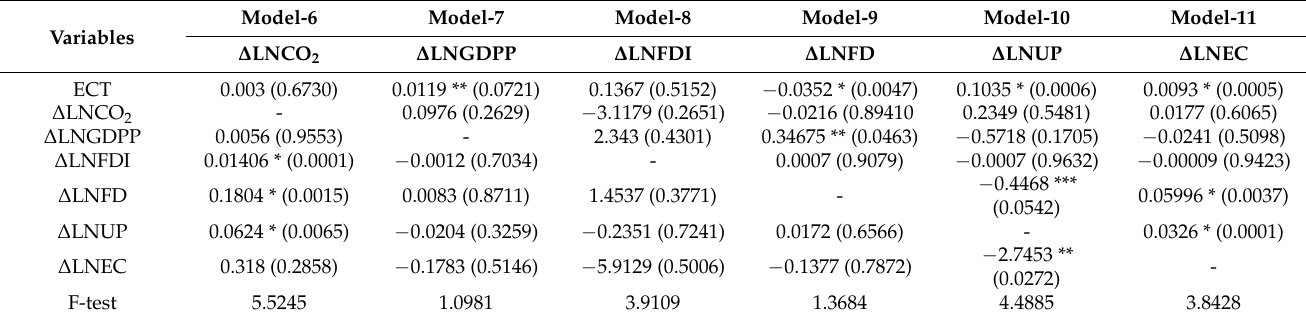
Table 8. Results of Panel Vector Error Correction Model (PVECM) for the Model